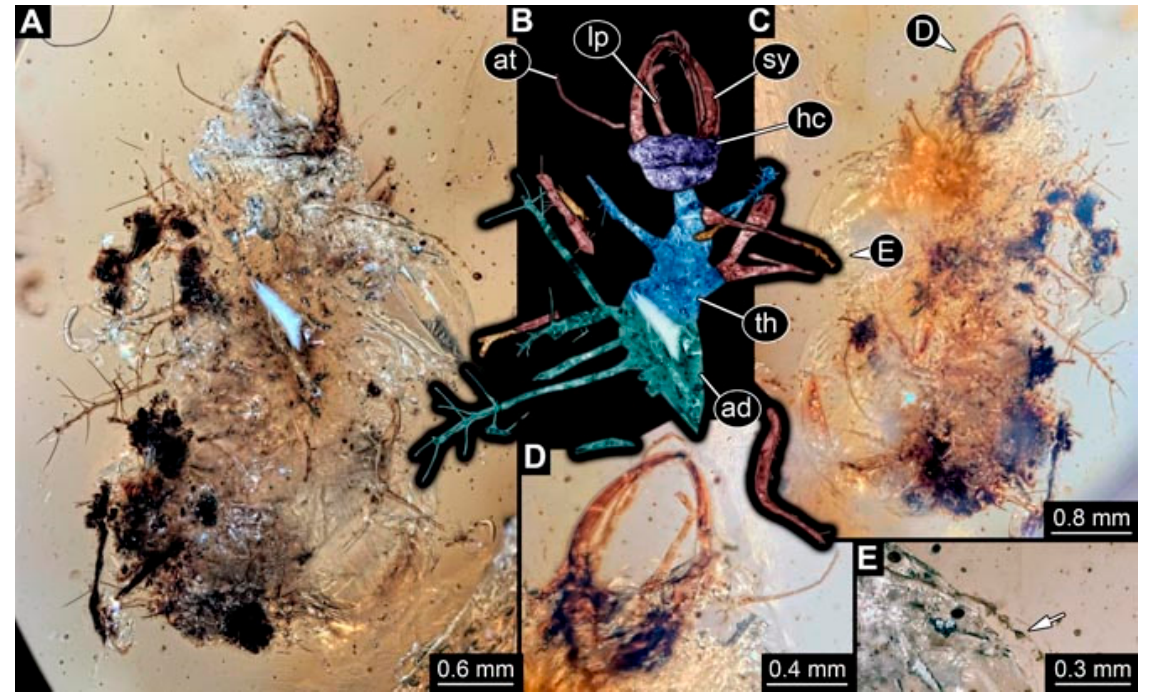
Figure 43. Specimen 4873 (PED 1323); Myanmar amber. ( A ) Ventral view. ( B ) Ventral view, colour- marked. ( C ) Dorsal view. ( D ) Close-up of head capsule in dorsal view. ( E ) Close-up of trunk appendage with empodium (arrow). Abbreviations: ad = abdomen; at = antenna; hc = head capsule; lp = labial palp; sy = stylet; th = thorax.